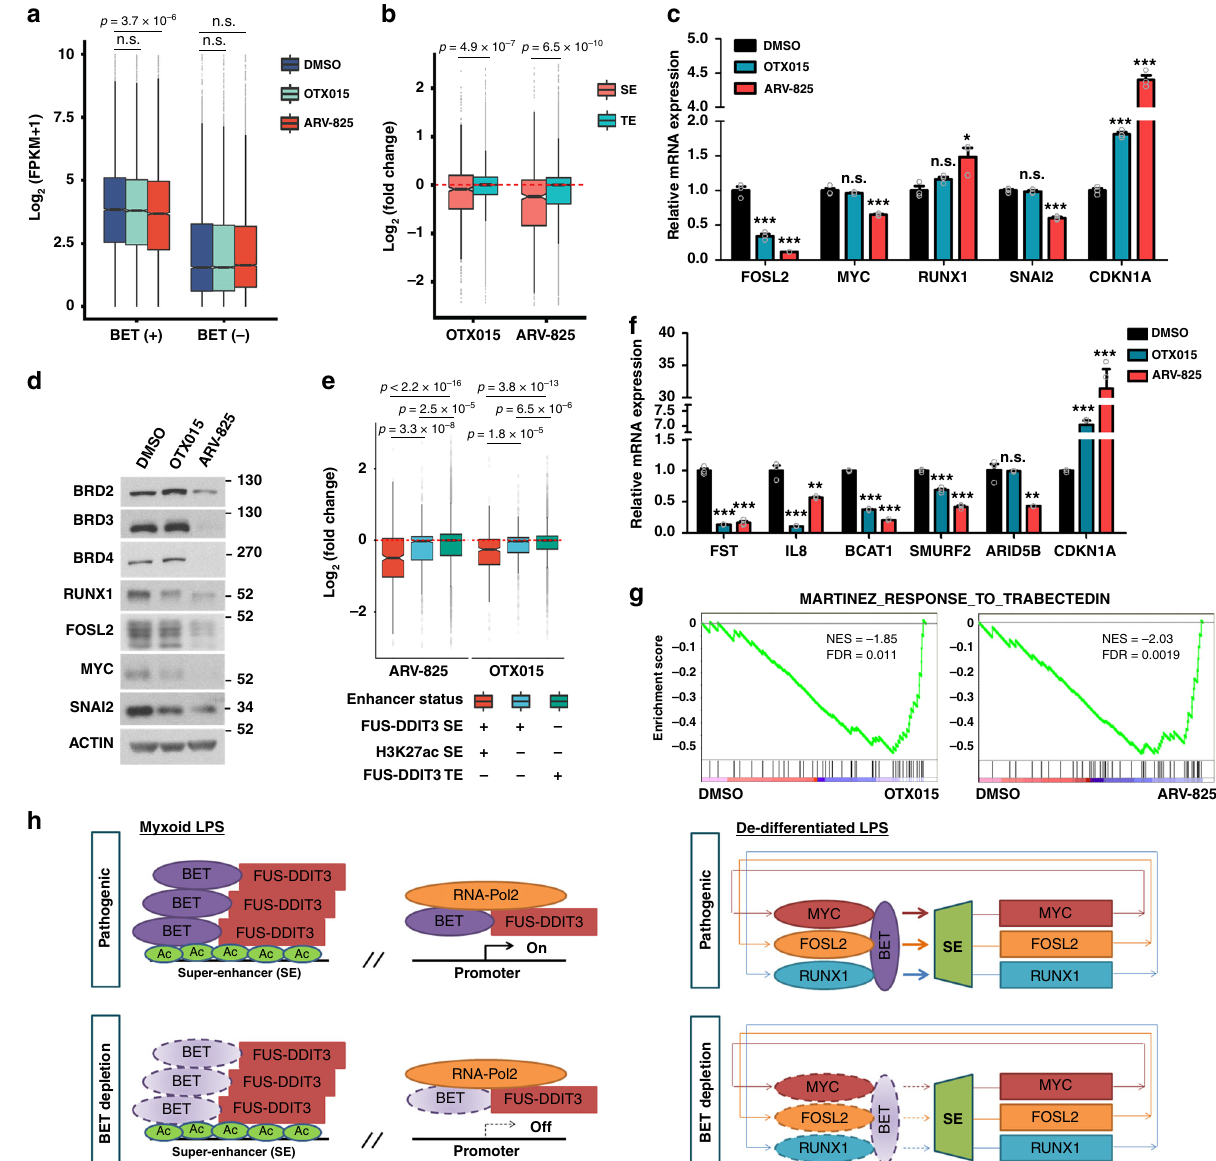
Fig. 6 BET protein degrader destroys the core transcriptional programs in liposarcoma (LPS). a Differential responses of genes to OTX015 and ARV-825 treatment according to BET protein occupancy around their promoter-proximal regions in LPS141 cells. BET( + ) denotes genes with at least one ChIP-seq peak of BET proteins within their promoter-proximal regions; BET( − ) denotes genes that are negative for binding of BET proteins. b Differential responses of genes to OTX015 and ARV-825 treatment according to enhancer status in LPS141 cells. c Quantitative reverse transcription PCR (qRT-PCR) analysis showing the mRNA levels of core TF genes, SNAI2, and CDKN1A upon ARV-825 and OTX015 treatment (200 nM, 24 h) in LPS141 cells. CDKN1A was used as positive control for differentially expressed genes. d Immunoblot analysis showing the impact of ARV-825 and OTX015 (200 nM, 24 h) on levels of BET proteins, core TFs, and SNAI2 in LPS141 cells. e Differential responses of genes to OTX015 and ARV-825 treatment (200 nM, 24 h) according to their enhancer occupancy by FUS-DDIT3 in MLS402 cells. f qRT-PCR analysis showing the mRNA levels of FST, IL8, BCAT1, and CDKN1A upon ARV-825 and OTX015 treatment (200 nM, 24 h) in MLS402 cells. CDKN1A was used as positive control for differentially expressed genes. Data are presented as mean ± SEM; n = 3. g GSEA plots of Trabectedin response pathway in MLS402 cells treated with dimethyl sulfoxide (DMSO) versus ARV-825 or OTX015. h Models of BET protein-dependent core transcriptional programs in myxoid LPS (MLPS) and de-differentiated LPS (DDLPS). Depletion of BET proteins serves as a common strategy to target these core transcriptional dependencies. Box plots indicate median value (center line), fi rst and third quartiles (box limits), as well as minimum and maximum values (whiskers) after excluding outliers (dots). Wilcoxon signed-rank test was applied for a , b , e ; one-way analysis of variance (ANOVA) was applied for c , f . n.s., not signi fi cant; * p < 0.05; ** p < 0.01; *** p < 0.001. Source data are provided as a Source Data fi le